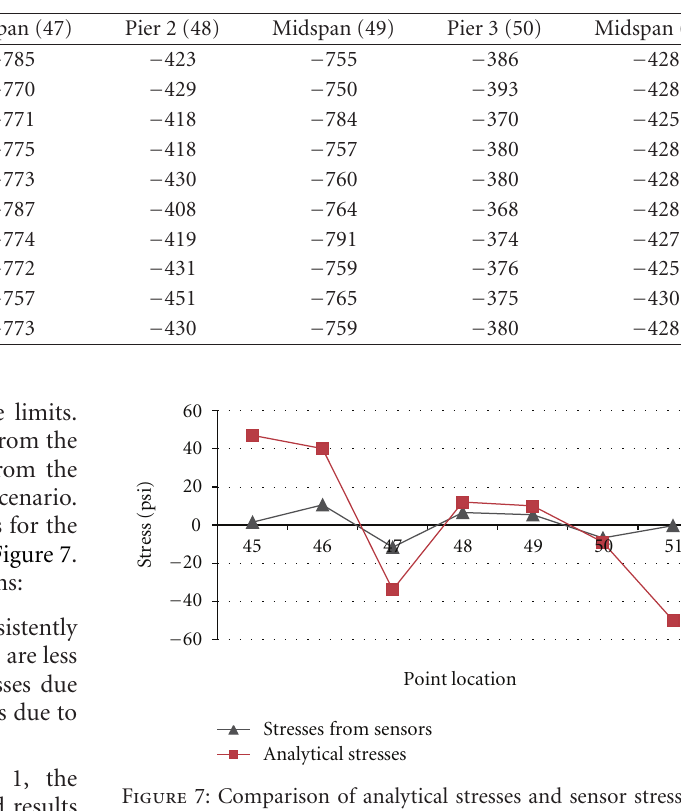
Table 11: Total stresses based on sensor readings—south (psi ∗ ).